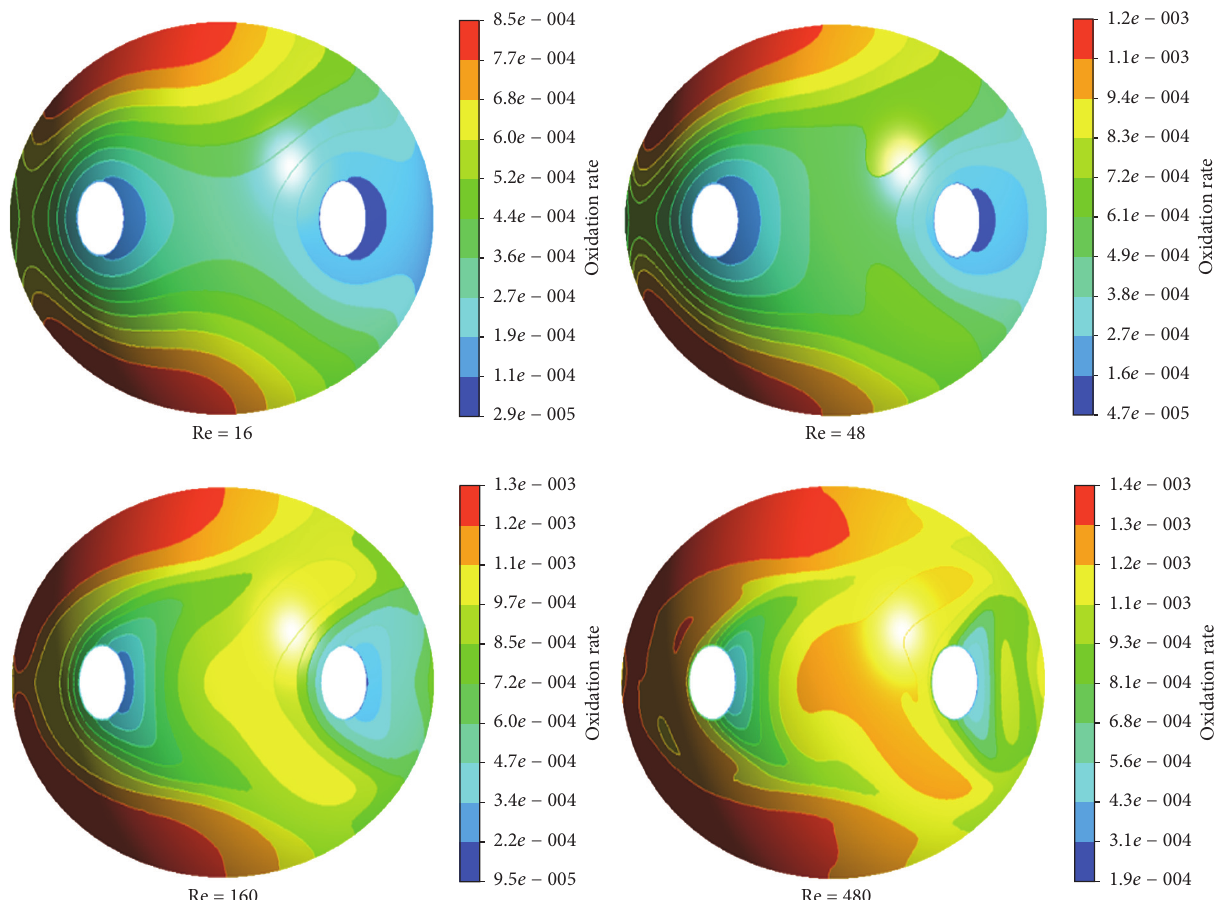
Figure 7: Distribution of oxidation rate with different Re number ( 𝑇 = 800 ∘ C).